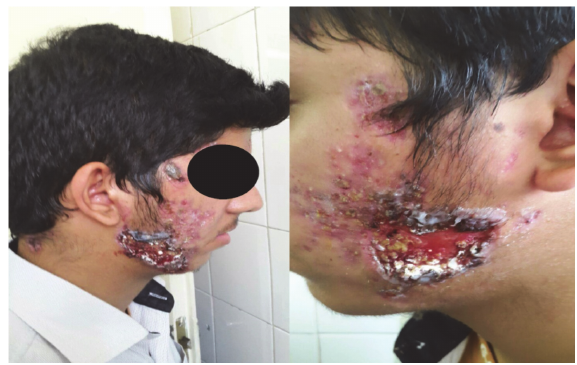
Figure 3: Acne fulminans after 28 days of oral prednisone and systemic antimicrobial